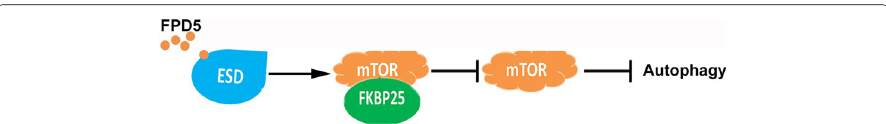
Fig. 6 Schematic diagram illustrating the mechanism of autophagy via